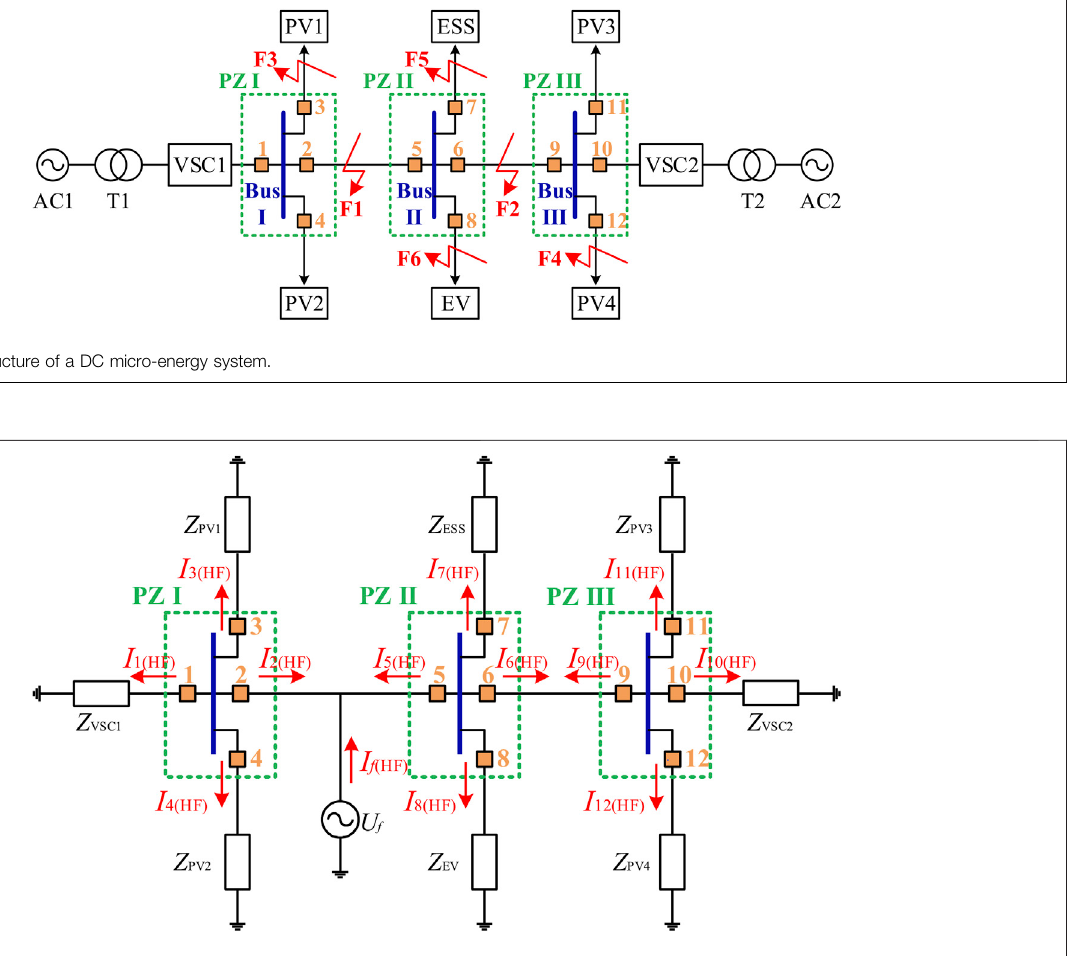
FIGURE 2 | Super-imposed network with fault